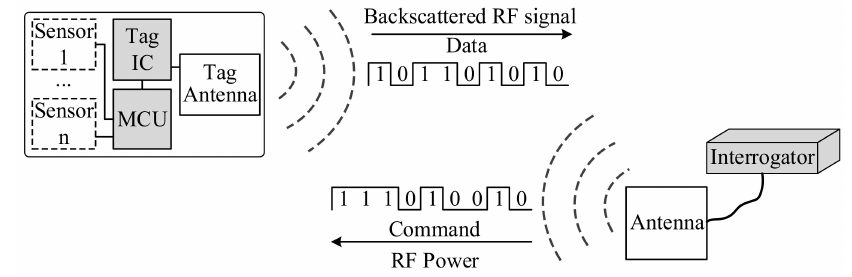
Figure 2. The Fundamentals of UHF RFID